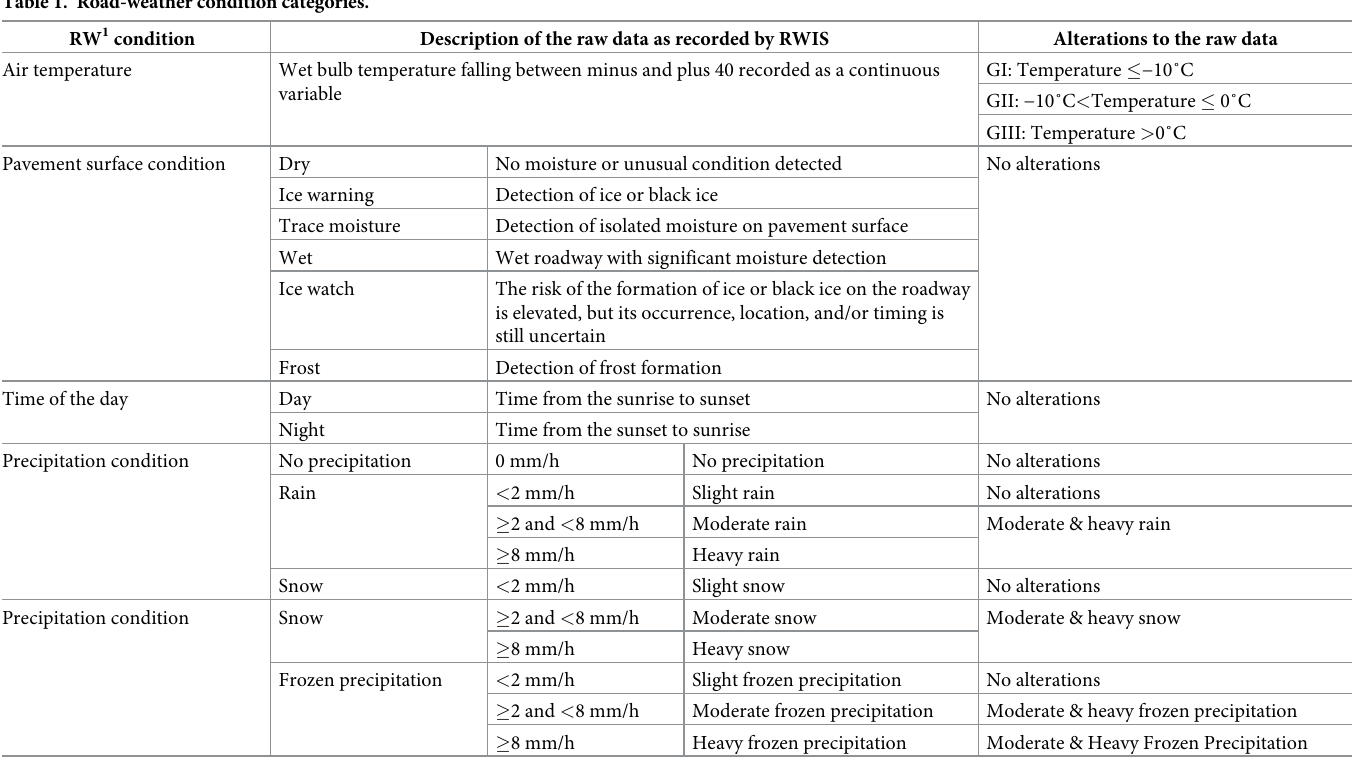
Table 1. Road-weather condition